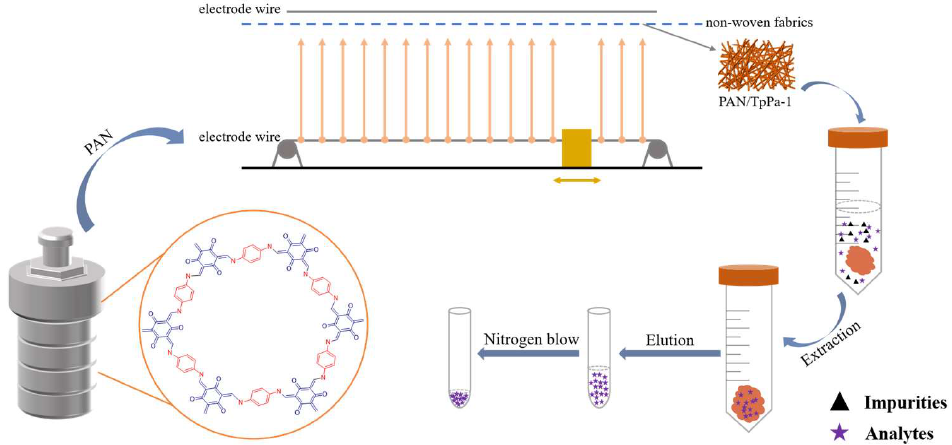
Figure 1. Schematic diagram of the preparation of PAN/TpPa–1 nanofiber and used as a dSPE adsorbent of QAs.